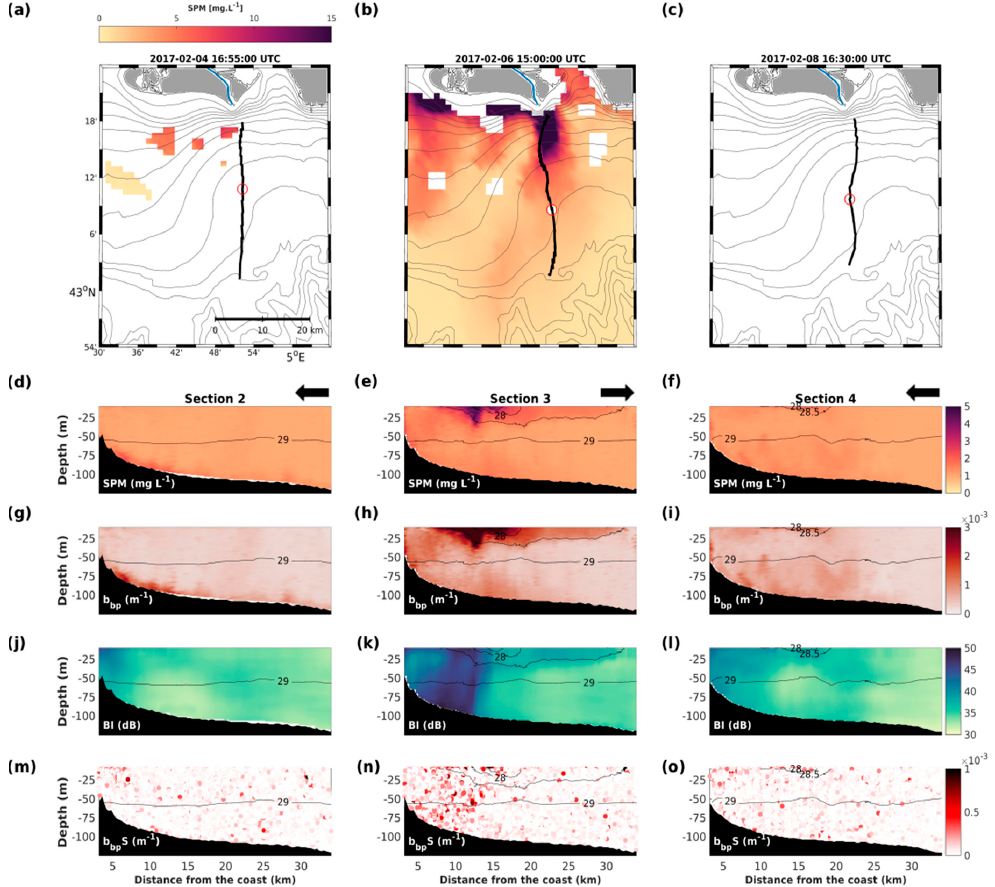
Figure 12. Surface turbidity from MODIS images ( a – c ) and glider measurements in the winter season: ( d – f ) suspended particle matter, ( g – i ) optical backscattering, ( j – l ) acoustic backscatter index, and ( m – o ) optical backscatter spikes. The left panels are estimates for Section 3, from 4–5 February 2017. The center panels are estimates for Section 4, from 5–7 February 2017. The right panels are estimates for Section 5, from 7–9 February 2017. The black arrows indicate the glider’s direction. For the top panels, the glider’s location at the time the satellite image was taken is shown by the red circle, and clouds and land are shown as white patches and gray areas,